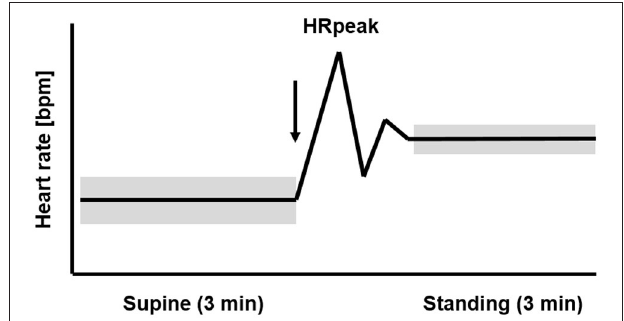
FIGURE 1 | Temporal course of the heart rate (HR) and heart rate variability (HRV) during 3min supine position followed by 3min standing position (orthostatic test, including HRpeak) in healthy athletes with uncompromised performance. The arrow marks the change in body position from supine to standing up. The widths of the bars represent the higher HRV in the supine than the standing position (mod. Hottenrott and Hoos,